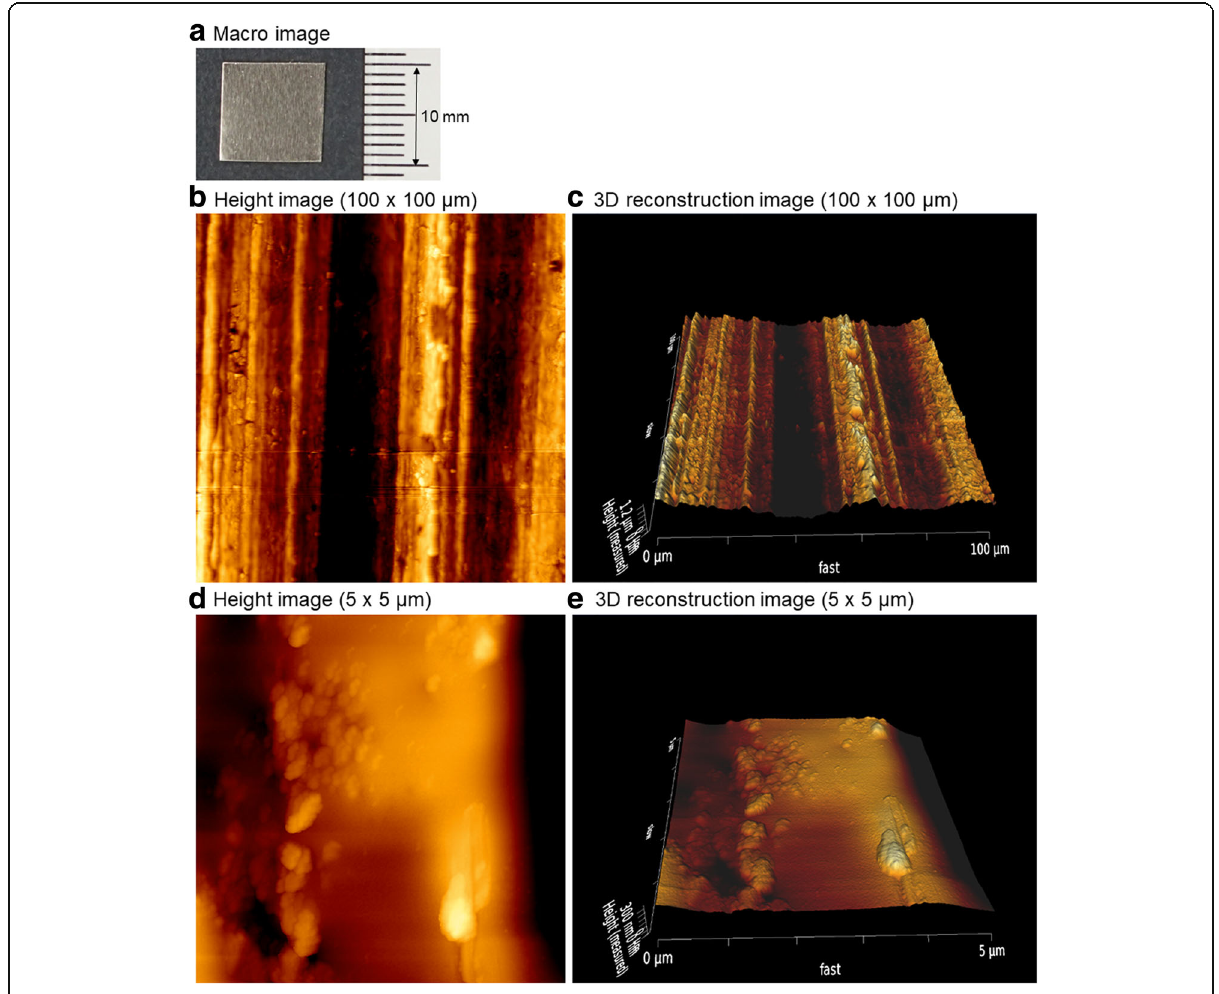
Fig. 1 a Macroscopic and b – e AFM images of the plain surface of cp -Ti plates. b , d Height images. c , e 3D reconstruction